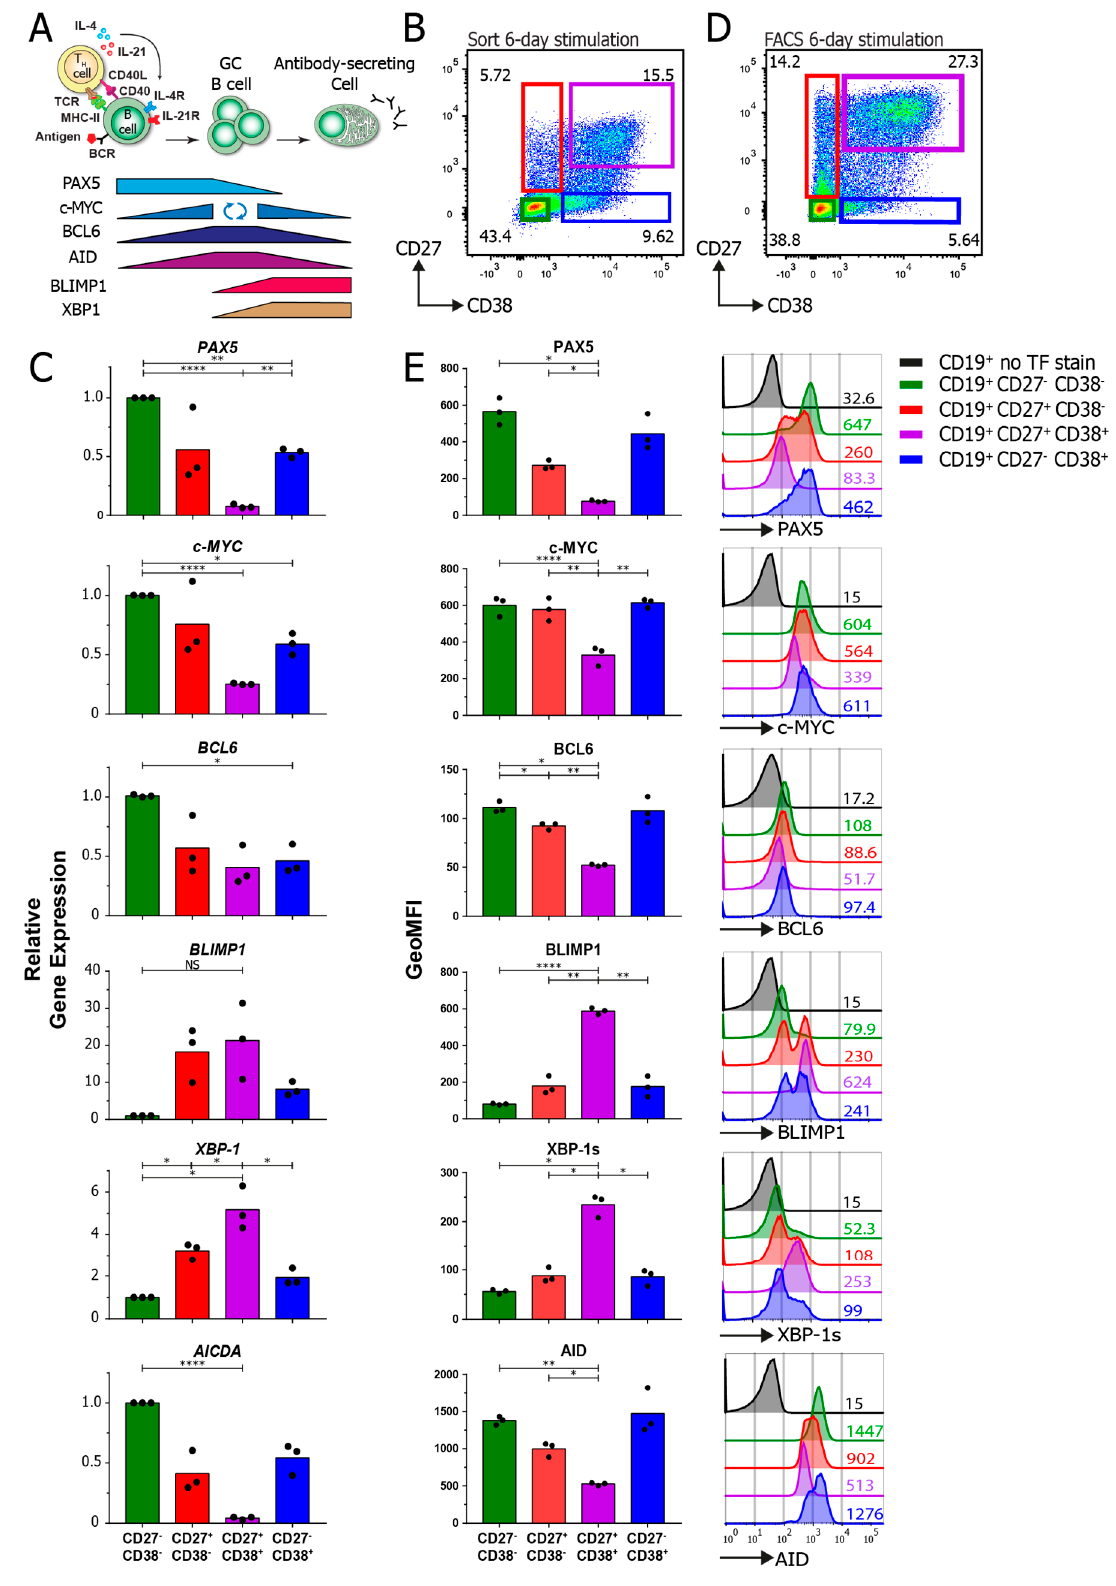
Figure 5. Transcription factor analysis in stimulated human B cells by flow cytometry. Human B cells ( n = 3) were stimulated with an anti-Ig F(ab)2 mix (5 ug/mL) and recombinant IL-4 (25 ng/mL) and IL-21 (50 ng/mL) cytokines for 6 days and analyzed for the mRNA and protein expression of multiple transcription factors. ( A ) Schematic representation of the expression of B cell-, GC cell- and ASC- defining transcription factors after T cell-dependent B cell stimulation. ( B ) Representative FACS plot of the sorting strategy for the CD27/CD38 subpopulations for analysis by semiquantitative RT-PCR.